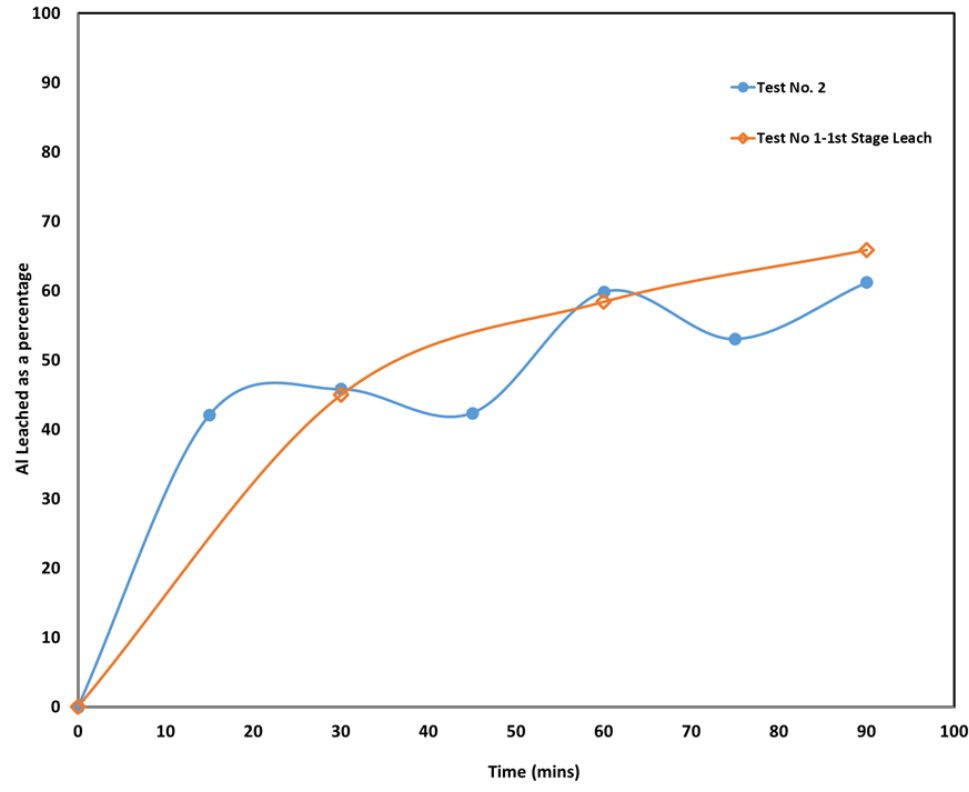
Figure 7 . Test no. 2 leaching of 100 g of slag in the presence of 4 g NaOH. Figure 7. Test no. 2 leaching of 100 g of slag in the presence of 4 g